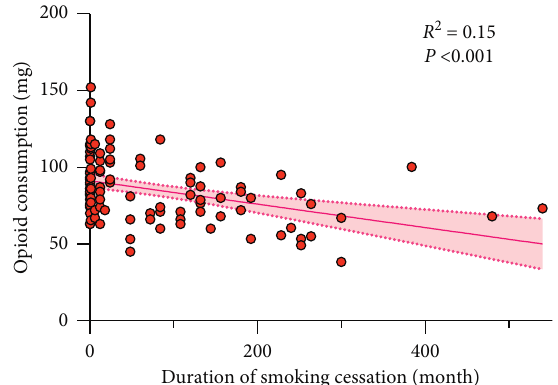
Figure 4: Comparison of numeric rating scale scores between the three groups according to postoperative day ∗ P value < 0.05 compared with G0. † P value < 0.05 compared with G2 PODs 0, 1, and 2 � postoperative days 0, 1, and 2, respectively. There was no significant difference between G0 and G2. The horizontal line inside the boxes shows the median values; the upper and lower edges of the box represent the third and first quartiles, respectively. The whiskers above and below the boxes represent 90% and 10%, respectively. Data were analyzed using the Kruskal–Wallis